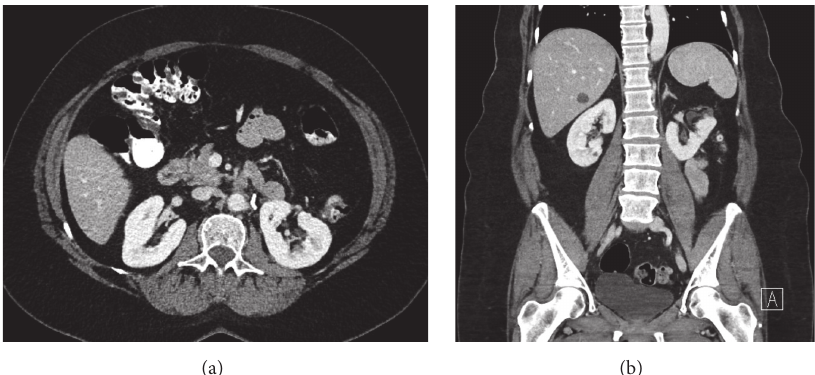
Figure 3: Axial (a) and coronal (b) views of abdominal CT showing recovered left kidney, ten months after partial nephrectomy for removal of a giant